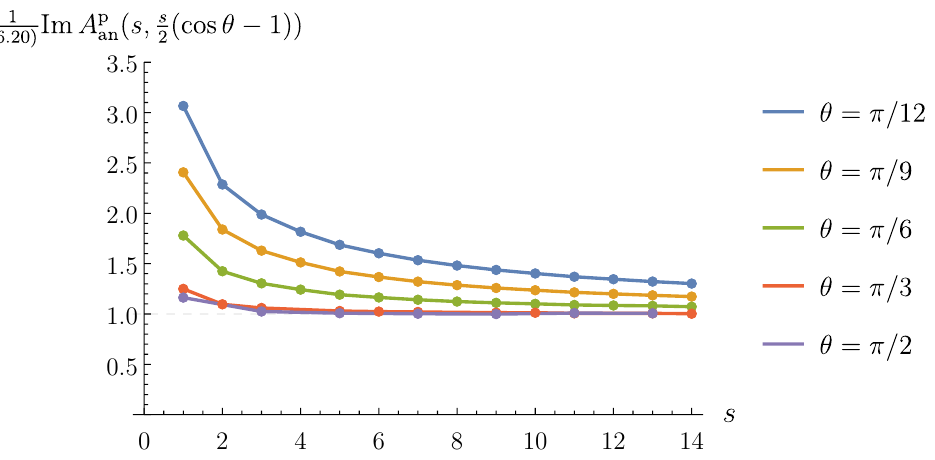
( s , s ( cos θ − 1 )) at fixed-angles θ extracted from Figure 28: Ratio between Im A p an 2 decay widths at integer s = n , and the analytic prediction from the right-hand side of (6.20). The ratio approaching 1 at higher and higher energies indicates exponential suppression of the imaginary part as ∼ e − S tree